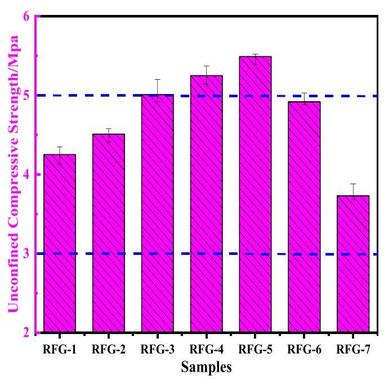
7d UCS of different proportions.